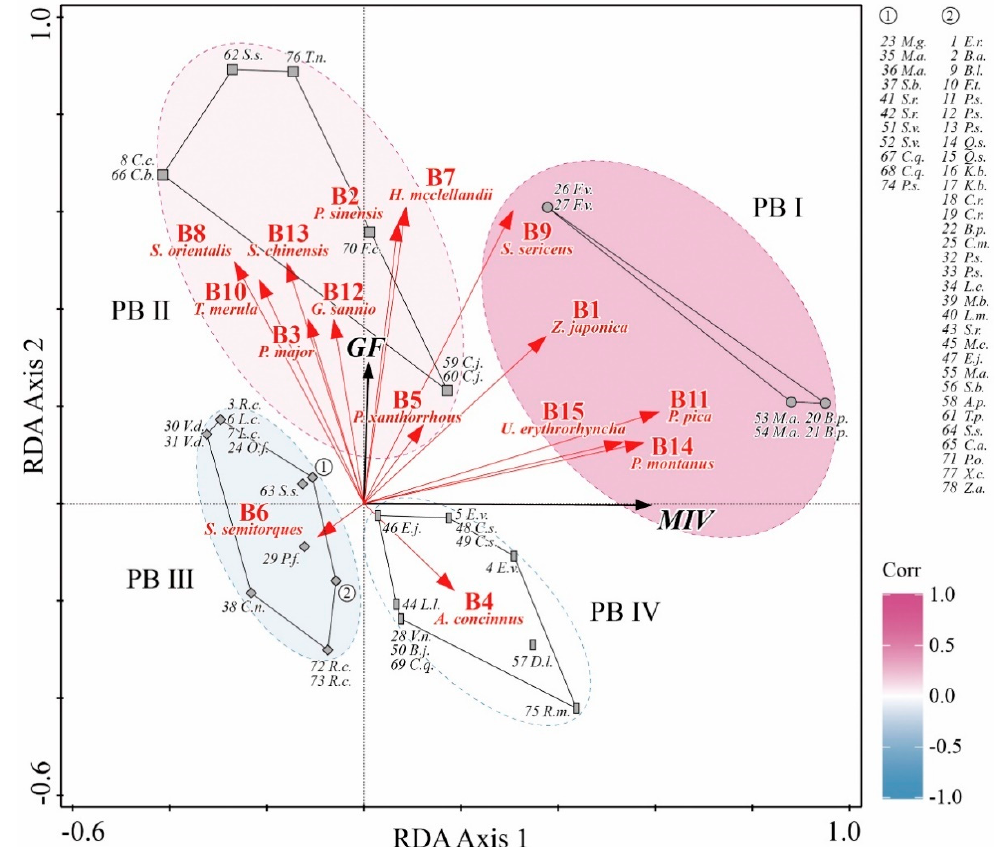
Figure 2. The ordination biplot of RDA of riparian forest plant species and frugivore bird communities along the riparian belt of the Jialing, Yulin and Kuxi Rivers in Chongqing, China. Black arrows are plant variables (response variable), in which MIV is mean relative importance value of plant species in same layers; and GF is plant growth form with the higher the value, the taller the plant. Number 1–78 are the vegetation species identifiers as elaborated in Supplementary Material Table S1, and indicated in the figure with species’ name of the genus plus the species initials; in addition, the dense coordinate points in the figure are marked as ① and ② , and the plant list is listed on the right. Four ellipses circle the different PBs: PB I (plant species symbol is circle), PB II (square), PB III (diamond), and PB IV (long rectangular). Legend corr means coefficient, and the ellipses’ color shades is proportional to the coefficient value, with red representing positive correlation and blue the opposite. The red arrows denote the frugivore birds, and the arrow lengths imply the dominant values of different species. Labels b1-b15 are Zosterops japonica (b1), Pycnonotus sinensis (b2), Parus major (b3), Aegithalos concinnus (b4), Pycnonotus xanthorrhous (b5), Spizixos semitorques (b6), Hypsipetes mcclellandii (b7), Streptopelia orientalis (b8), Sturnus sericeus (b9), Turdus merula (b10), Pica pica (b11), Garrulax sannio (b12), Streptopelia chinensis (b13) Passer montanus (b14), and Urocissa erythrorhyncha (b15), which are indicated as species’ genus abbreviation plus name adjective. The solid line envelopes and the ellipses represent the vegetation species clusters and the plant–bird assemblages, respectively.